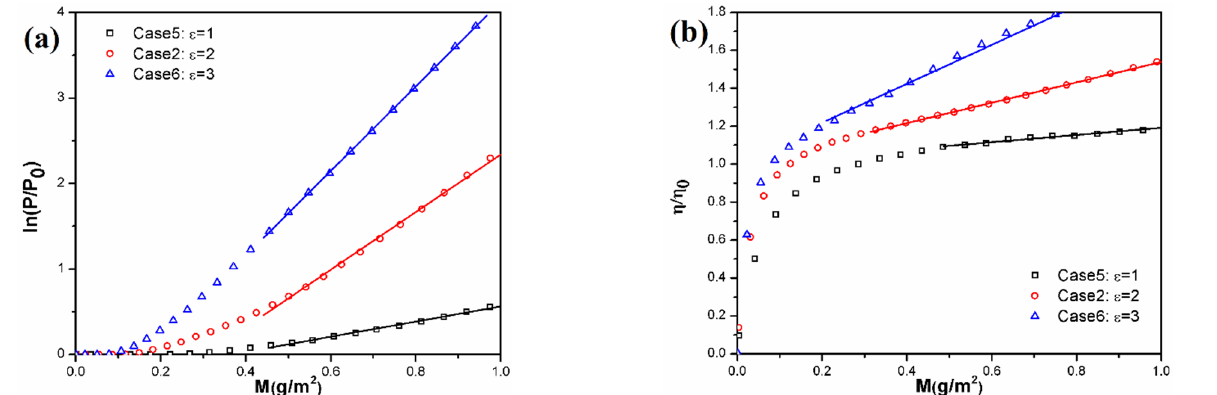
Figure 8. ( a ) Logarithmic scaling of the normalized pressure drop and ( b ) dynamic changes in the normalized capture efficiency with different aspect ratios.